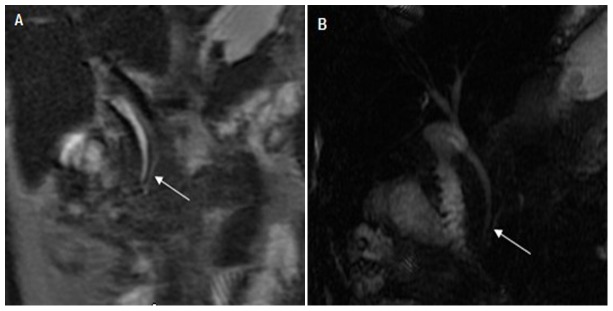
A 47-year-old female with acute pancreatitis.The Acute Physiology And Chronic Healthy Evaluation II score was 13, and magnetic resonance severity index was 10. (A) Coronal single-shot fast spin-echo T2WI and (B) magnetic resonance cholangiopancreatography show only the head of the main pancreatic duct (MPD) and the MPD visualized flair (arrows).